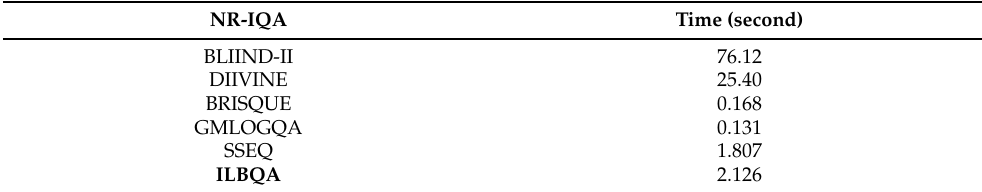
Table 10. Comparison of time complexity for different BIQA